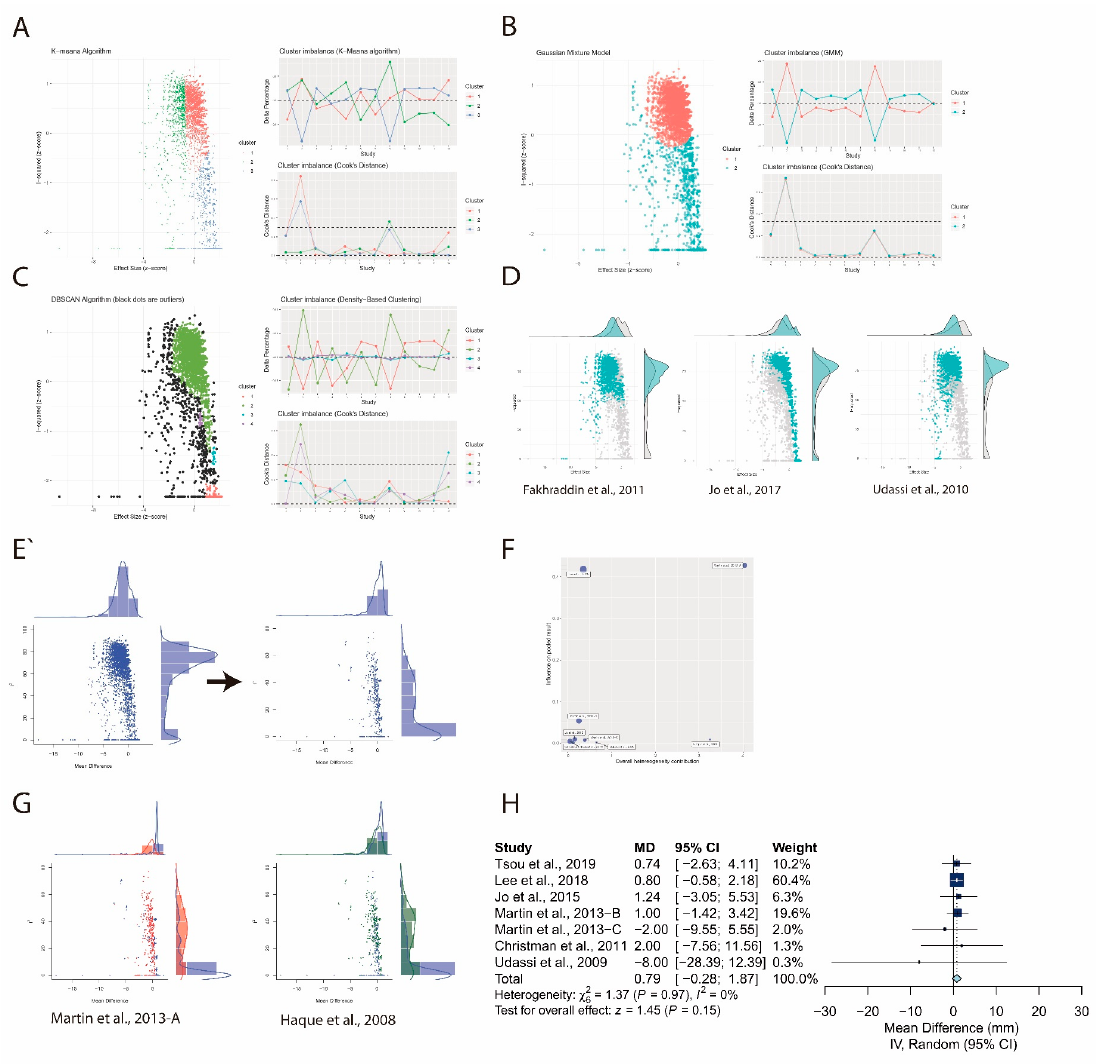
Figure 15. (A,B,C) potential outliers identified by three unsupervised learning algorithms; (D) GOSH plots with the corresponding subsets including the potential outliers colored in green; (E) left plot: the original GOSH plot; right plot: the GOSH plot after excluding the potential outliers in the first round; (F) Baujat plot containing the remaining studies after excluding the potential outliers in the first round; (G) GOSH plots with the corresponding subsets including the potential outliers identified from the Baujat plot colored in red and dark green; (H) forest plot after excluding all the potential outliers.